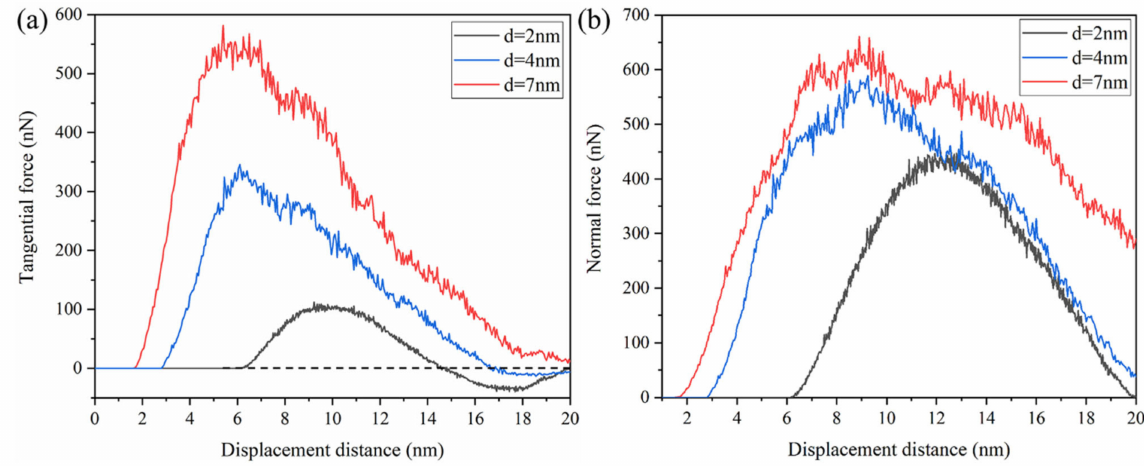
Figure 17. Evolution of ( a ) tangential force and ( b ) normal force at different depths of 2 nm, 4 nm and 7 nm.